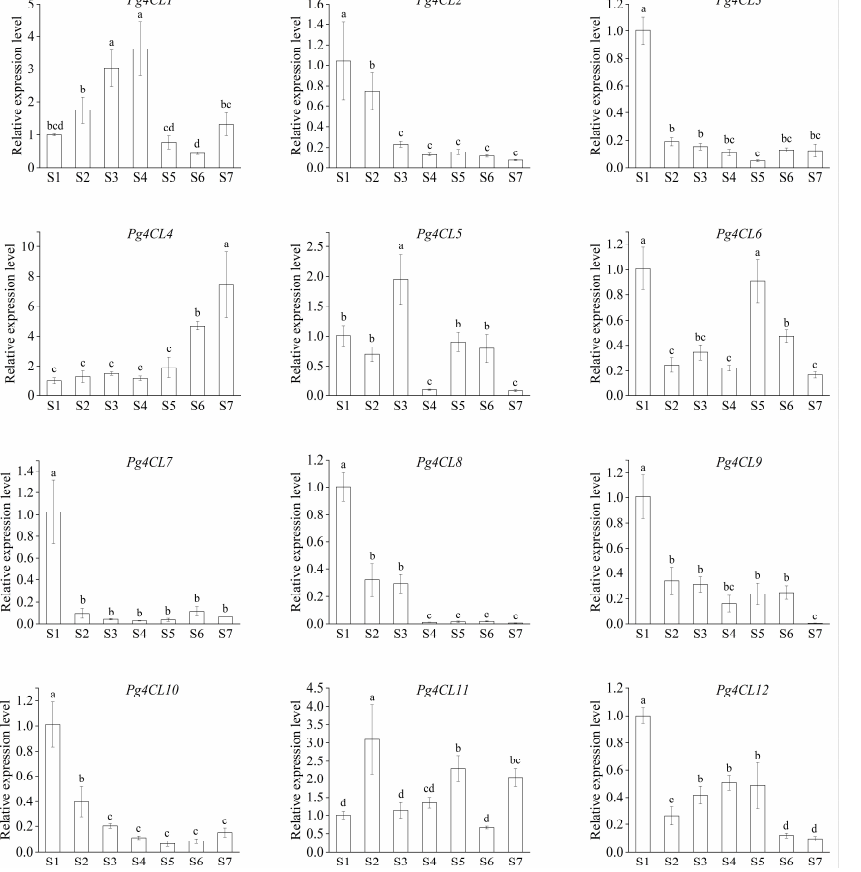
Figure 10. Relative expression levels of 12 Pg4CL from the pericarp during fruit development. Note: the seven stages of fruit development were S1, S2, S3, S4, S5, S6, and S7, and the specific dates of the seven stages were 15 July, 28 July, 10 August, 23 August, 5 September, 18 September, and 1 October, respectively. The vertical bar in the bar graph is standard error. Bars with different letters (a–d) indicate significant differences at p < 0.05 according to Duncan’s test.